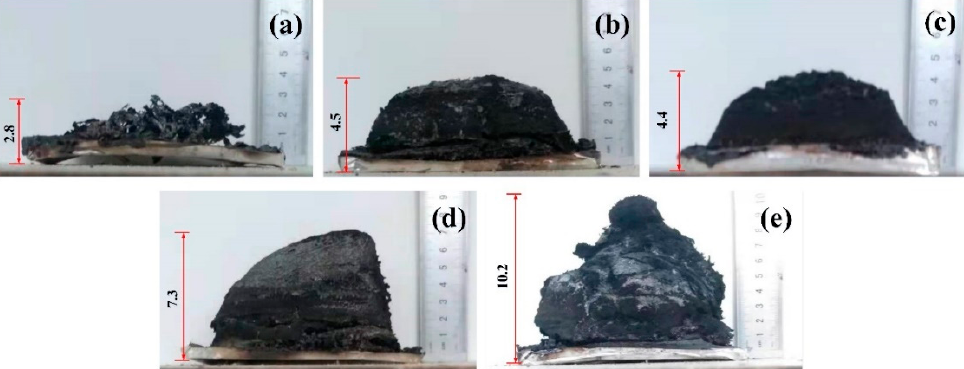
Figure 11. Digital photographs of the char residues obtained after the cone calorimeter test: ( a ) EP, ( b ) EP/10APP, ( c ) EP/5DDP, ( d ) EP/10DDP, and ( e ) EP/15DDP.